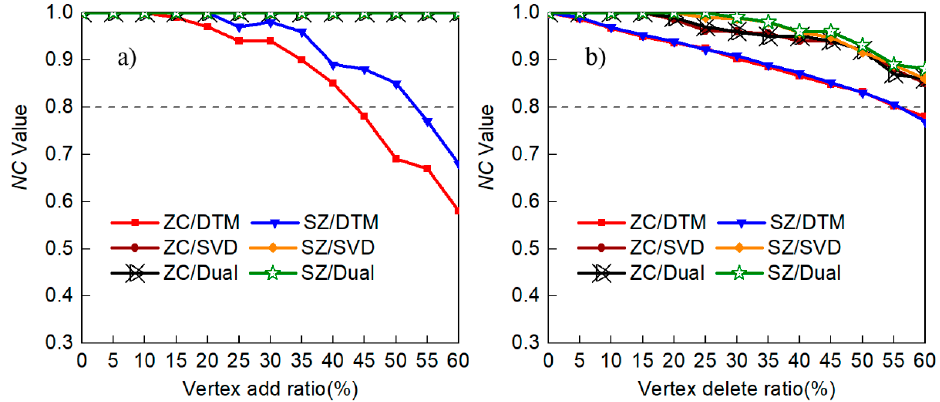
Figure 6. The NC change curves under increased levels of ( a ) randomly added vertices and ( b ) randomly deleted vertices.